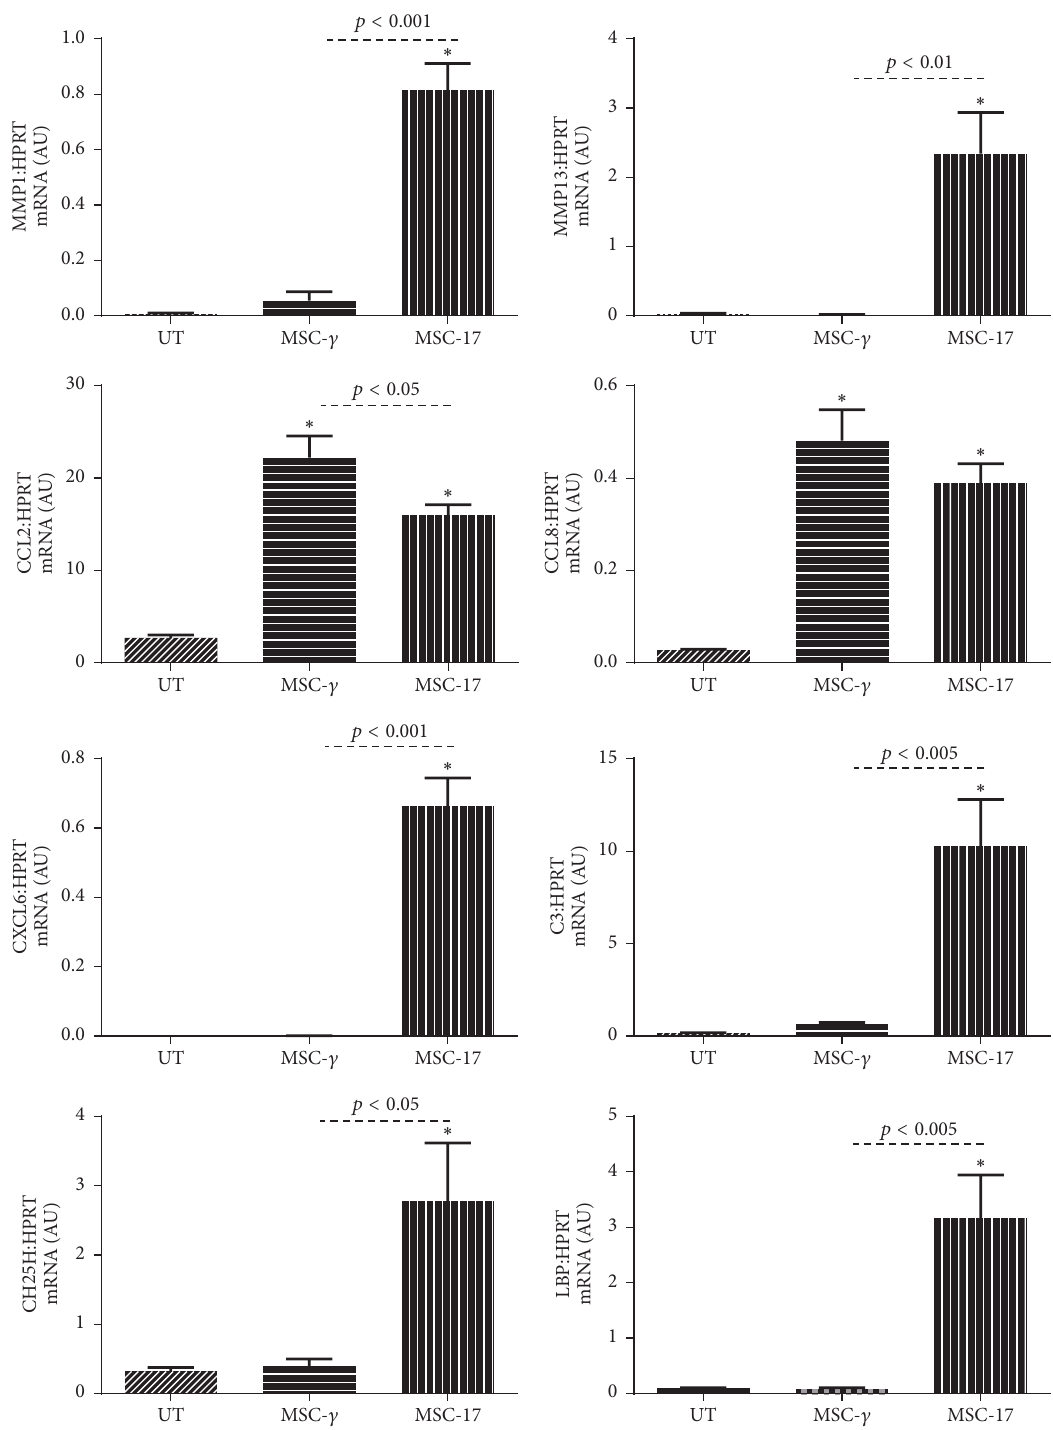
Figure 4: Microarray gene expression validation by RT-PCR. Gene expression of MMP1, MMP13, CCL2, CCL8, CXCL6, C3, LBP, and CH25 in MSC detected by microarray was validated by RT-PCR following 5 days of IL-17A or IFN- 𝛾 treatment of human MSC. ∗ 𝑝 < 0.05 versus UT-MSC was determined by one-way ANOVA with post-Sidak multiple comparison test. Data are representative of 3 human MSC donors. Error bars depict mean ±